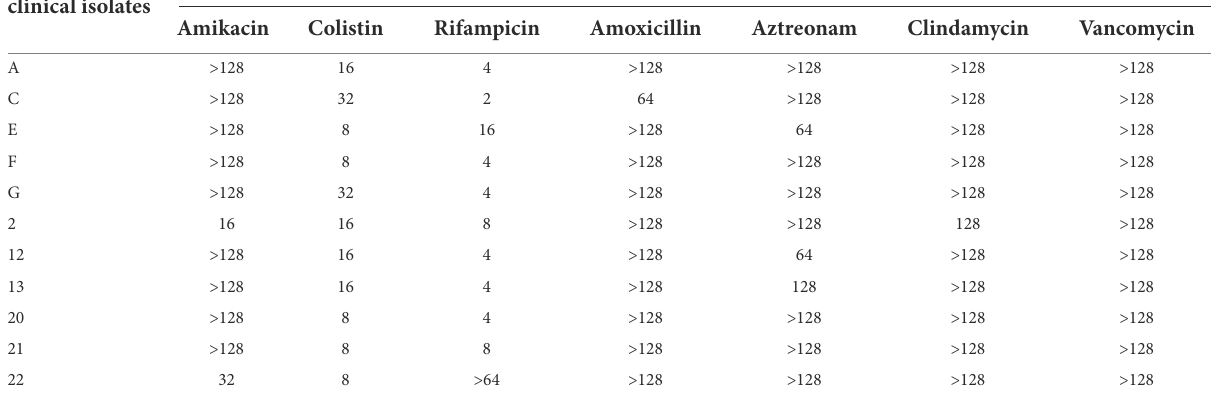
TABLE 2 Minimum inhibitory concentrations of various antibiotics as monotherapy against clinical isolates of A. baumannii , showing resistance to common